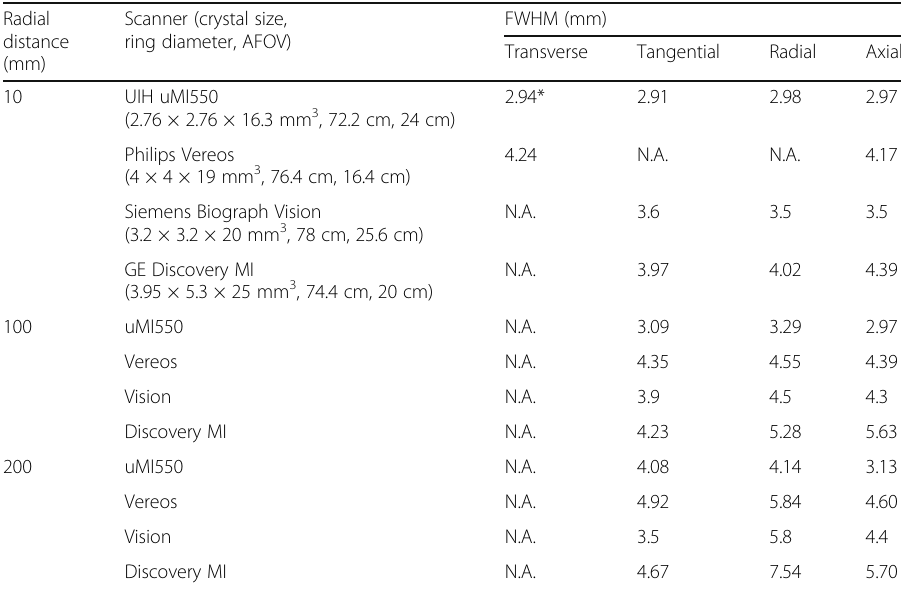
Table 3 The comparison of spatial resolution measurement results (FWHM) among uMI550, Siemens Biograph Vision, Philips Vereos, and GE Discovery MI (20 cm AFOV) Radial Scanner (crystal size, distance ring diameter, (mm)